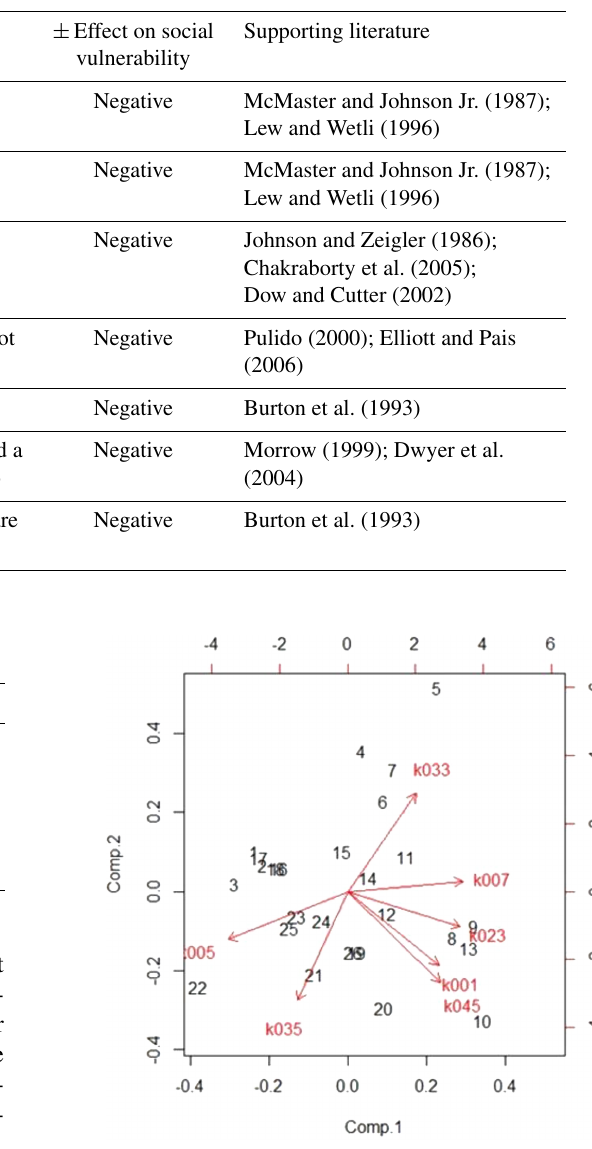
Table 2. 2011 UK census data variables used as the indicators to assess social vulnerability to flooding.